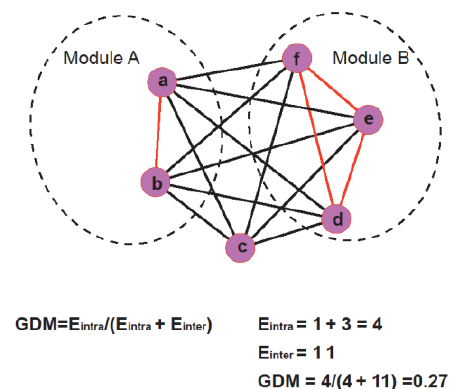
Figure 1. Schematic diagram of calculating GDM (genset-distribution in modules) of gene sets in the network. The formula for GDM and its calculation process were provided for the given example in the chart below.